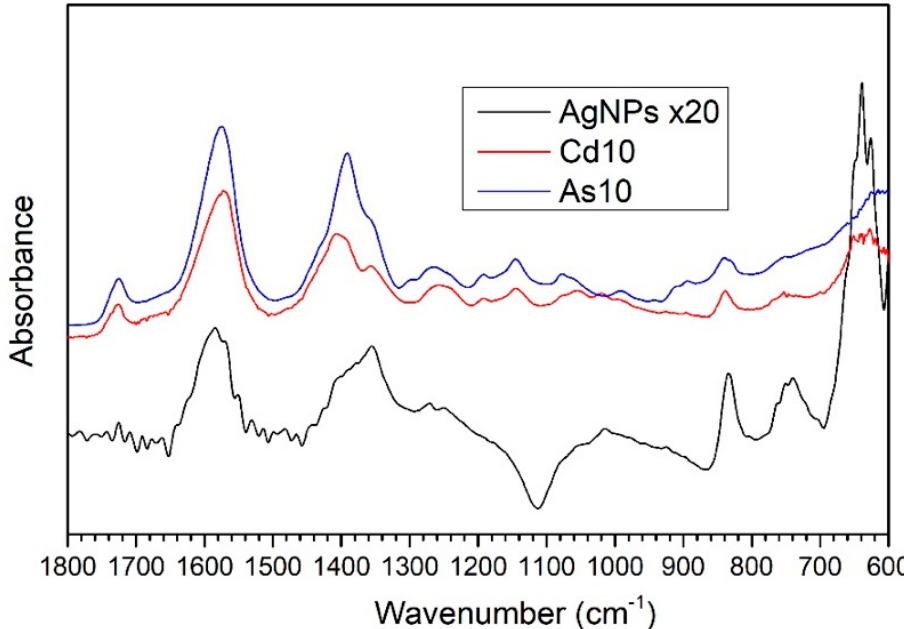
Figure 5. FTIR spectra in the 1800–600 cm − 1 range of samples As10 and Cd10, treated with 10 ppm solutions of As (III) and Cd (II) ions, respectively, and for the untreated reference sample, AgNPs. The AgNPs reference spectrum was multiplied × 20 in order to obtain a similar intensity for the three spectra.